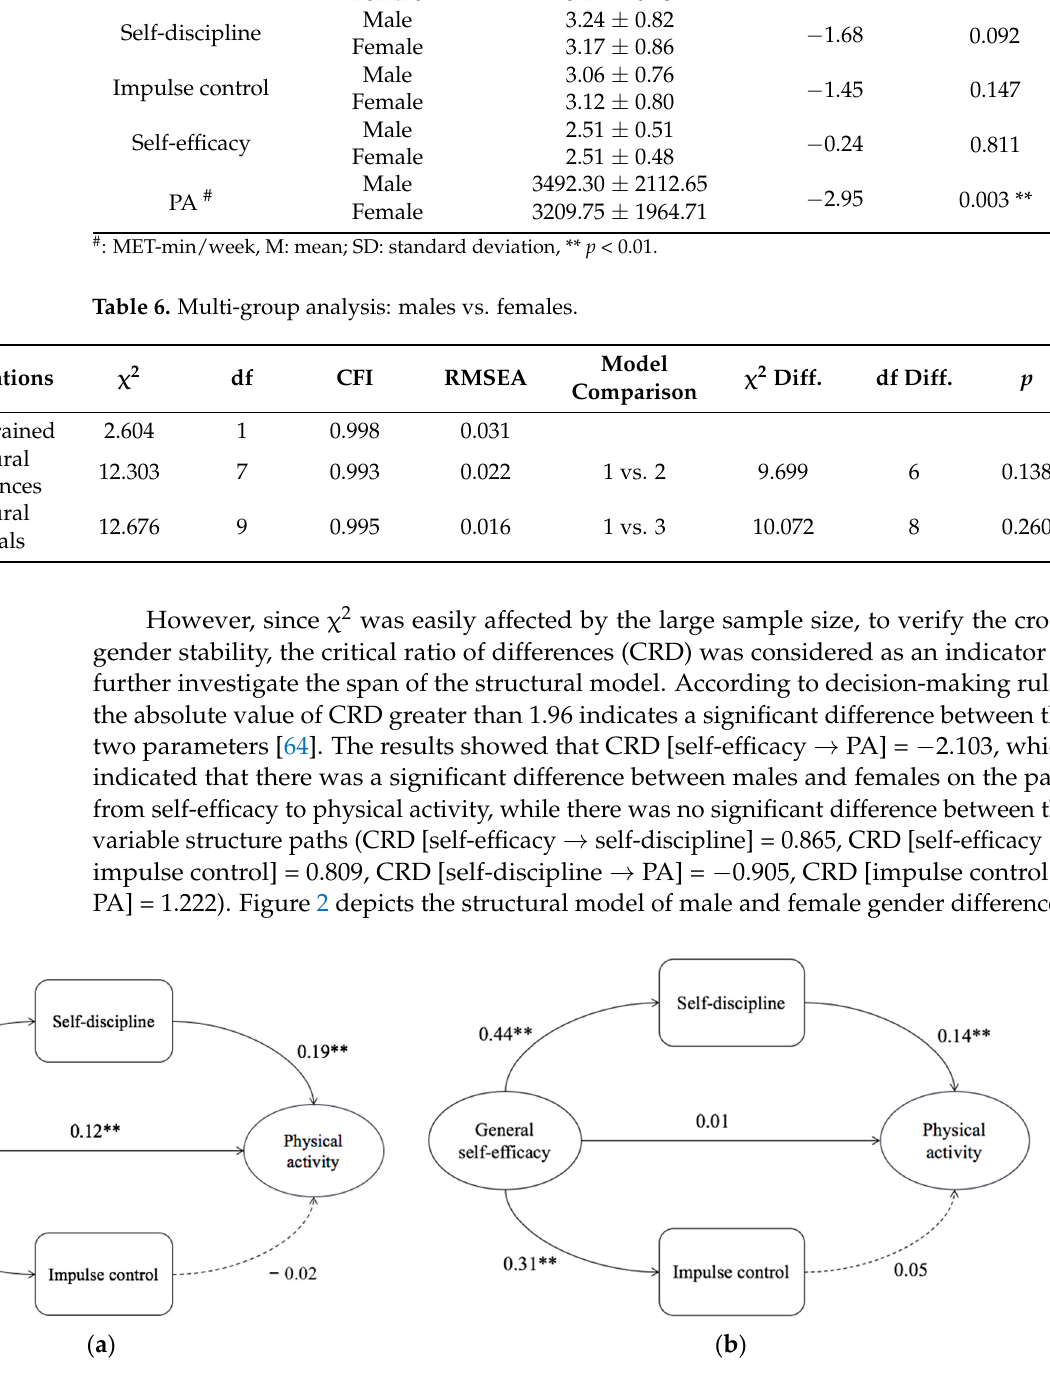
Figure 2. Parallel mediation model: ( a ) males; ( b ) females.( ** p < 0.01)